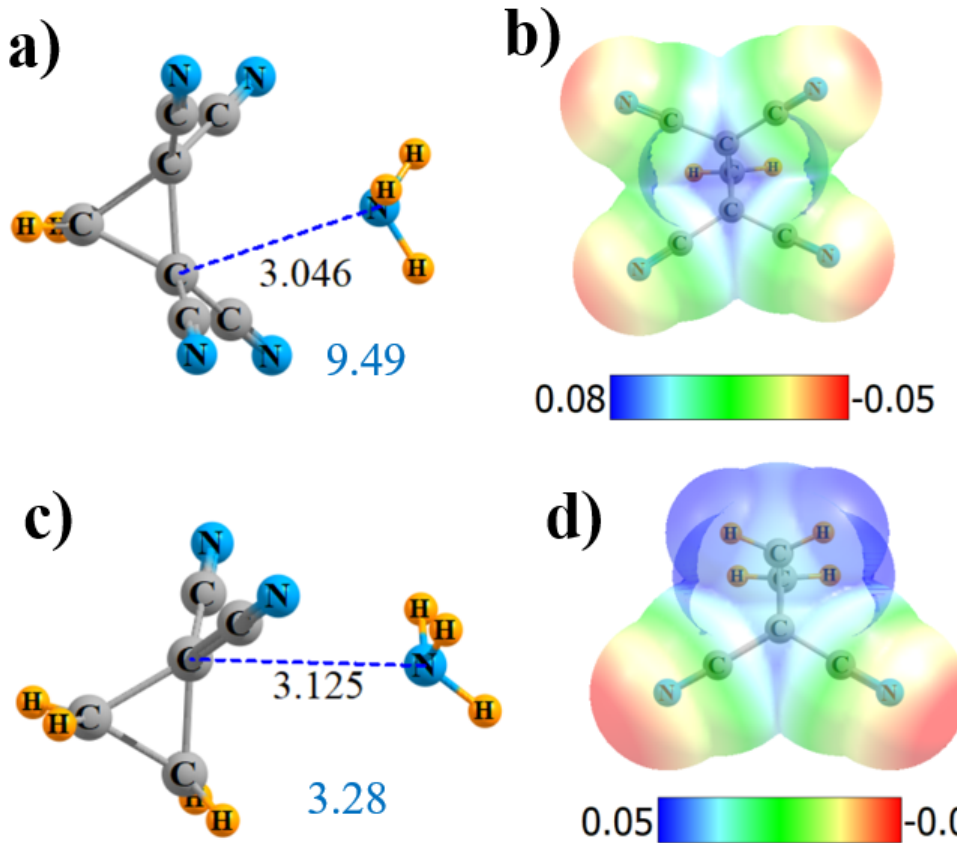
Figure 5. Geometries and monomer MEP of the complex of NH 3 with cyclic Lewis acids CH 2 {C(CN) 2 } 2 ( a , b ) and CH 2 CH 2 C(CN) 2 ( c , d ).